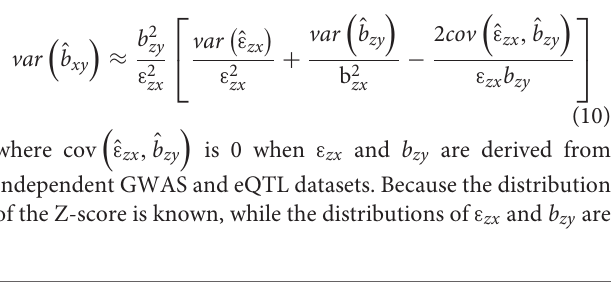
TABLE 1 | Ten of the top 20 significant genes and related